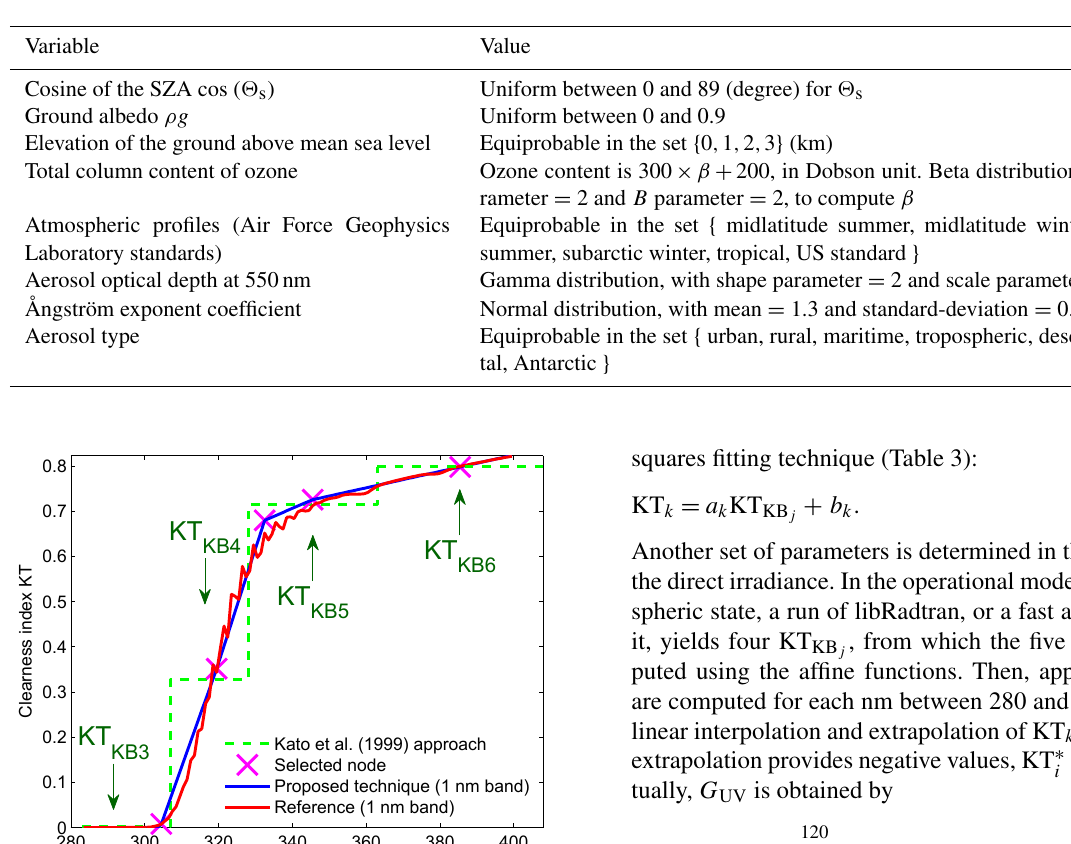
Table 2. Ranges and statistical distributions of values taken by the cosine of the solar zenith angle, the ground albedo and the 7 variables describing the clear atmosphere.